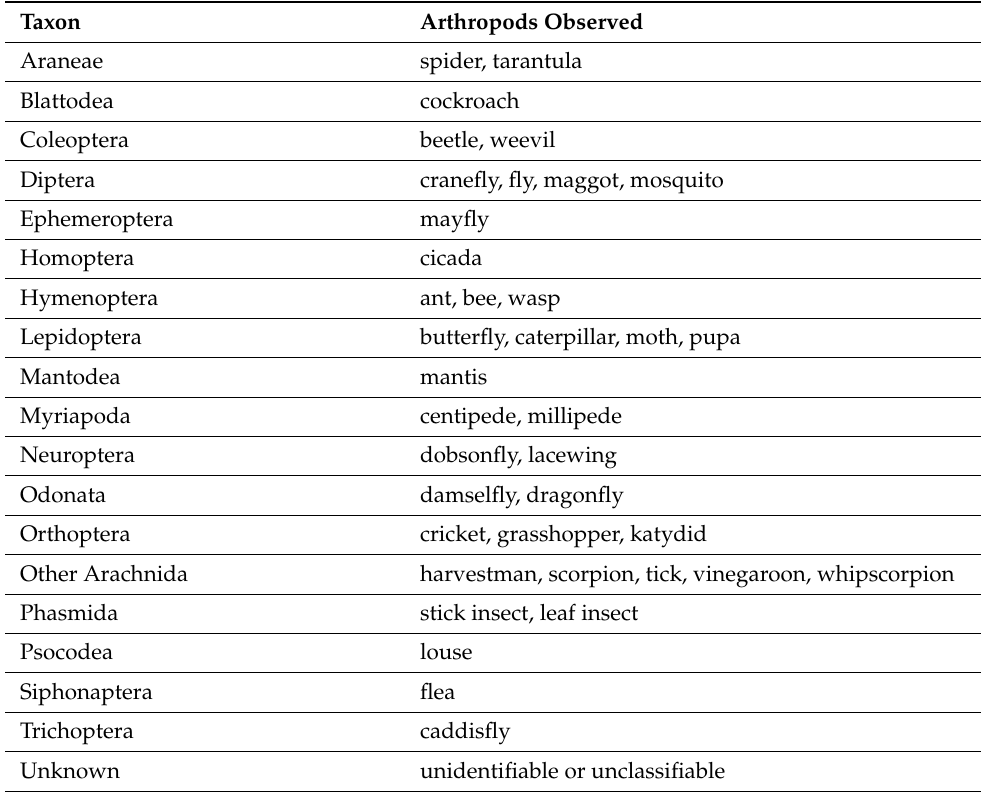
Table 1. The grouping of arthropod taxa observed in the